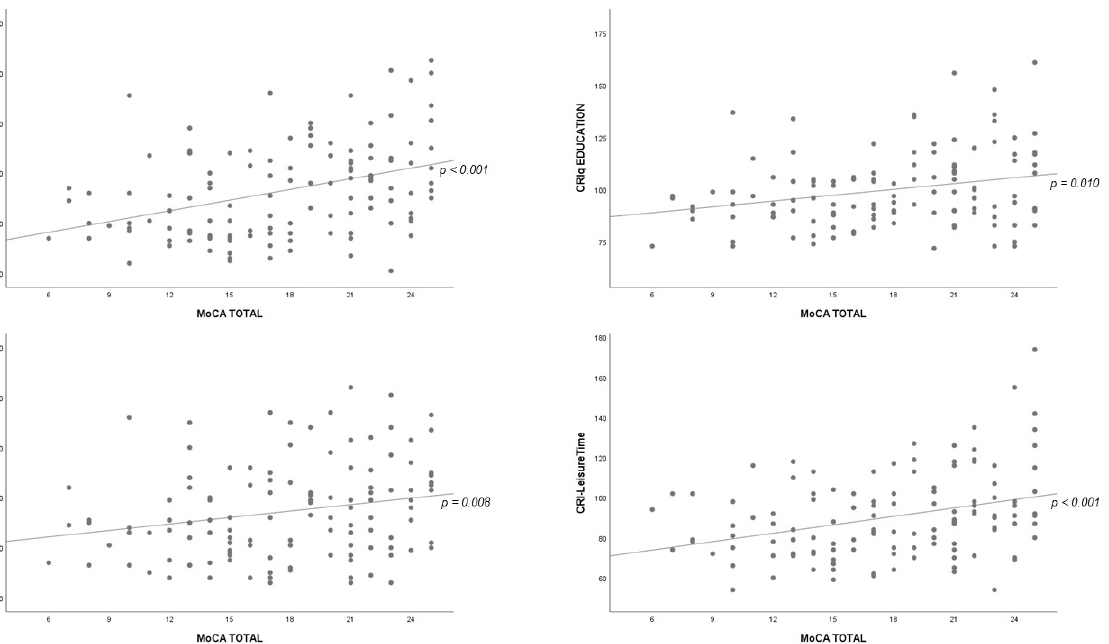
The results of analysis of bivariate correlations of MoCA scores with CRIq as the total score and the three subdomains are shown in Table 4. Positive significant correlations were